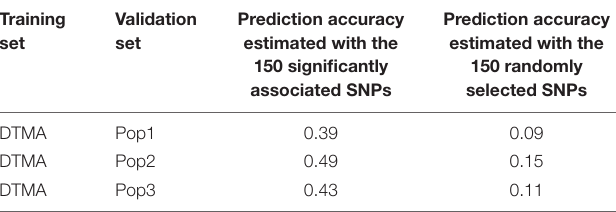
TABLE 3 | Genomic prediction accuracies in the DH populations of Pop1, Pop2, and Pop3 estimated with the 150 significantly associated SNPs and the same number of randomly selected